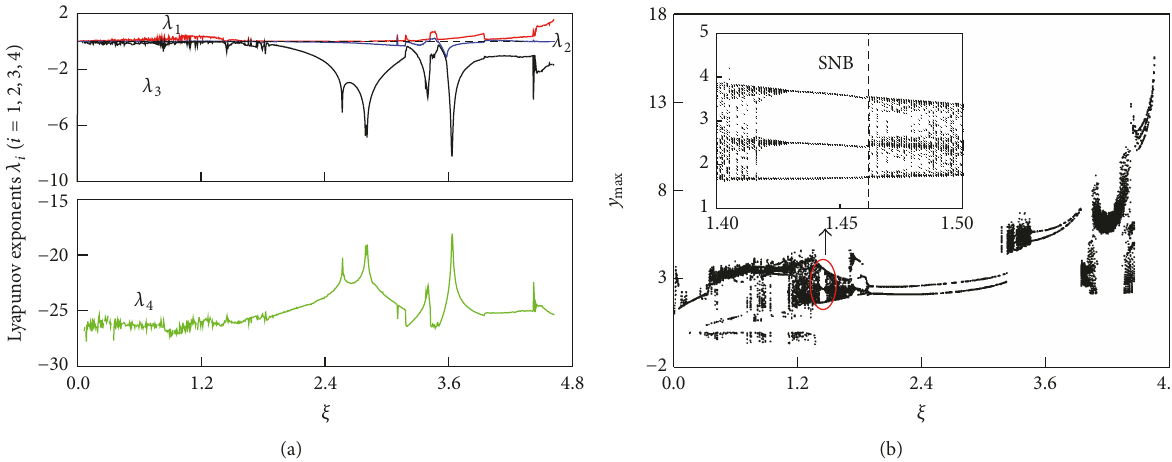
Figure 2: Lyapunov exponents and bifurcation diagram with parameter 𝜉 changing (a) 𝑙 1 = 0 , Lyapunov exponents, and (b) 𝑙 1 = 0 , bifurcation diagram.